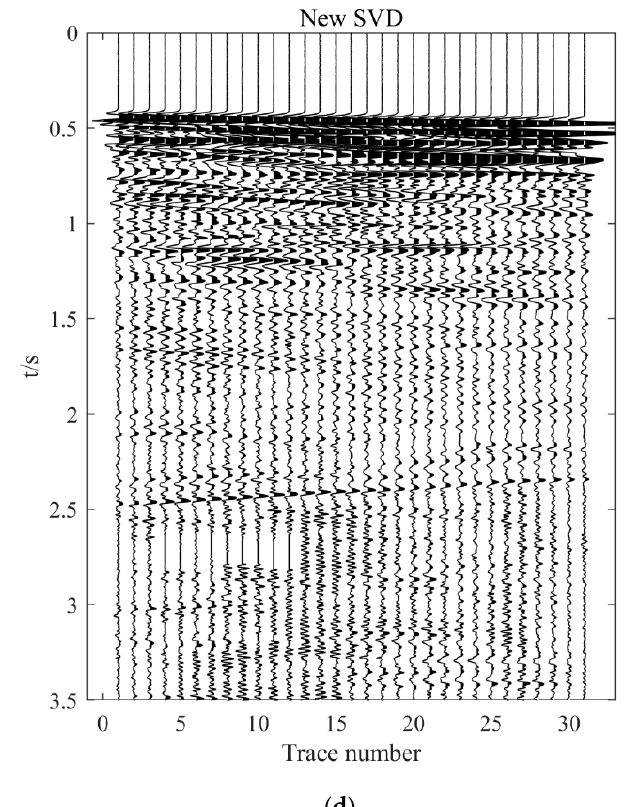
Figure 10. ( a ) Original field seismic data; filtered results achieved using conventional SVD filtering with ( b ) K = 1 and ( c ) K = 2; ( d ) improved SVD filtering.